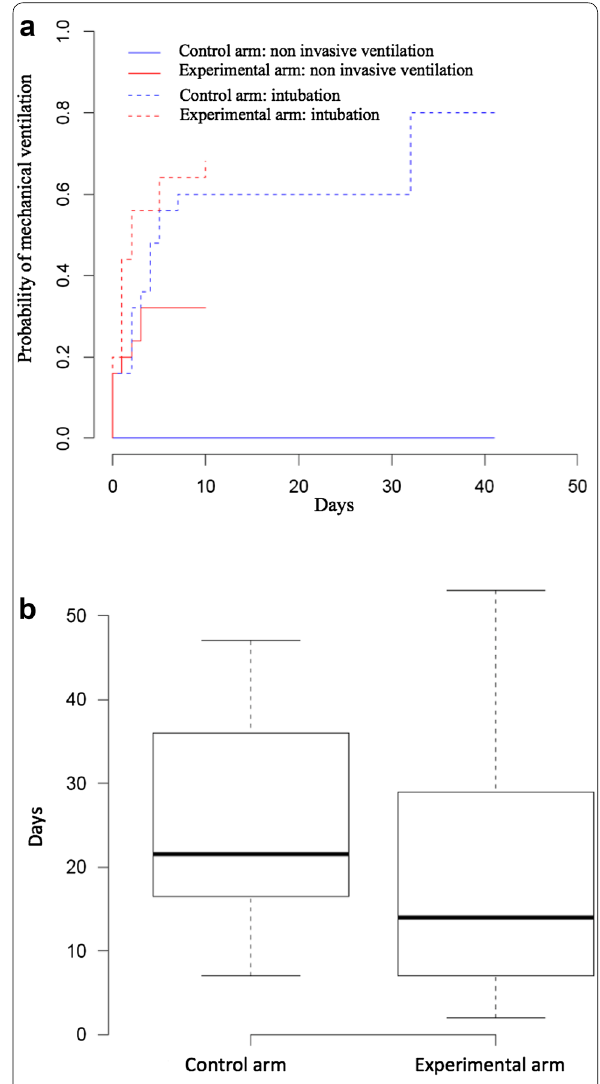
Fig. 3 Cumulative incidence and time on mechanical ventilation. a Cumulative incidence of mechanical ventilation. b Time on mechanical ventilation